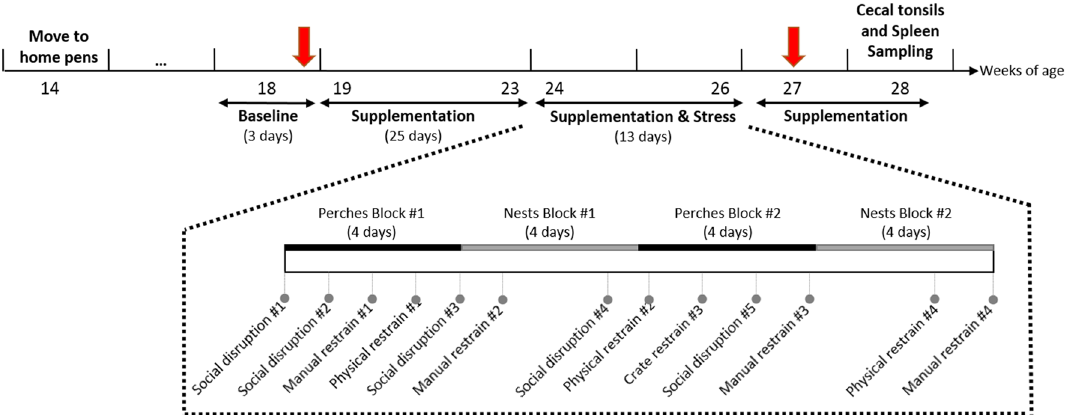
Figure 6. Schematic diagram of experimental timeline. Schematic diagram of experimental timeline. Laying hens were moved to the experimental pens at 14 weeks of age (woa). The supplementation with L. rhamnosus (Lacto) or a placebo (Placebo) started at week 19 and lasted until the end of the experiment. The stress treatment spanned weeks 24–26. Physical examinations, blood and fecal sampling (red arrows) were conducted at 18 woa (as a baseline) and 27 woa. Behaviors were recorded during week 18 and weeks 24–26. Spleen and cecal tonsils samplings were performed at 28